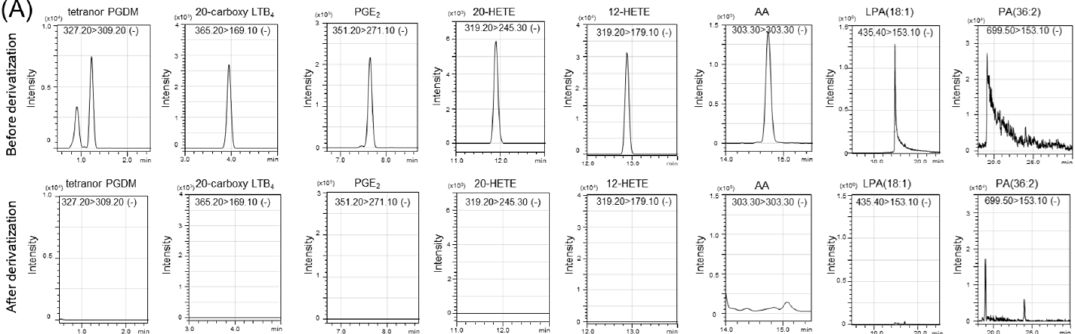
Figure 2. Chemical reaction schemes. ( A ) Tandem mass tag (TMT) derivatization for the phosphate group. ( B ) TMT derivatization for the carboxy group.